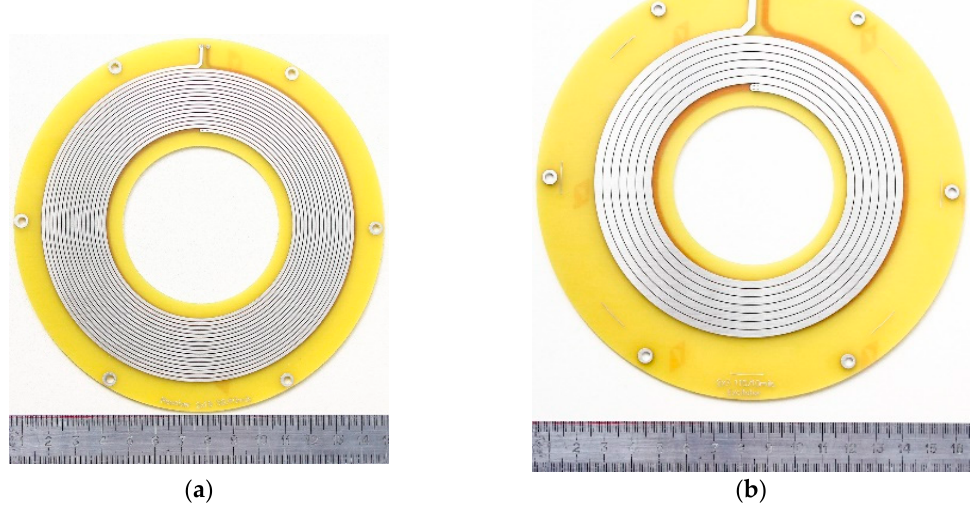
Figure 8. PCB coils of the proposed CET: ( a ) Receiver coil, ( b ) Excitation coil.